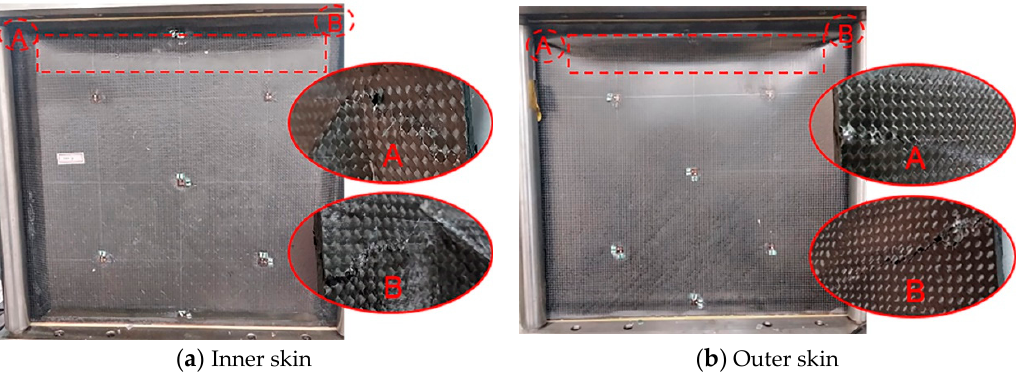
Figure 10. Compressive failure mode of CD0-3. ( a ) Failure mode of inner skin; ( b ) Failure mode of outer skin.